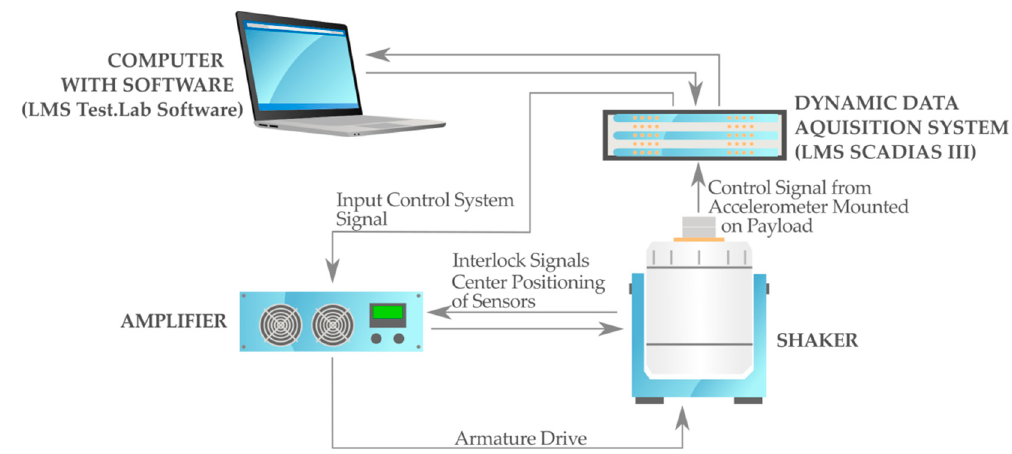
Figure 5. The laboratory armature of the electro-dynamical vibration exciter.